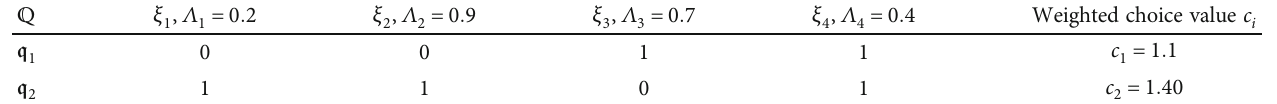
Table 2: Tabular representation of Γ = ð τ , H , Λ Þ with weighted choice